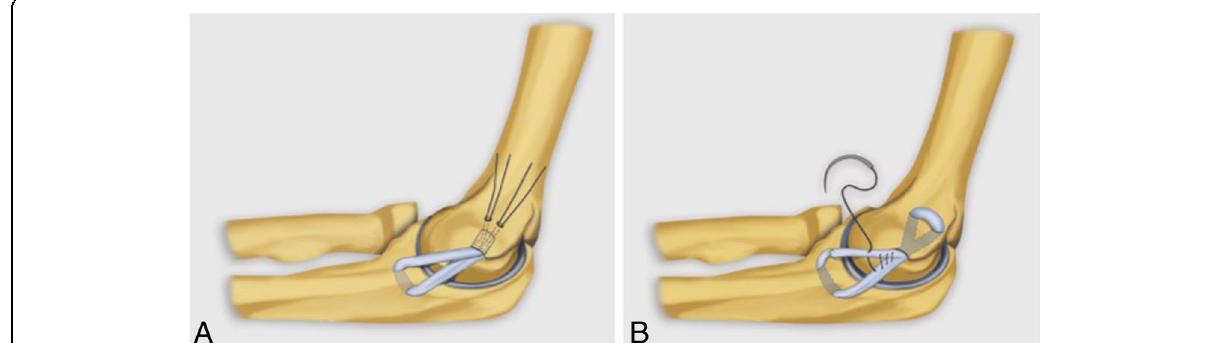
Fig. 37 Elbow illustrations demonstrating docking technique ( a ) and Jobe technique ( b ) for medial collateral ligament